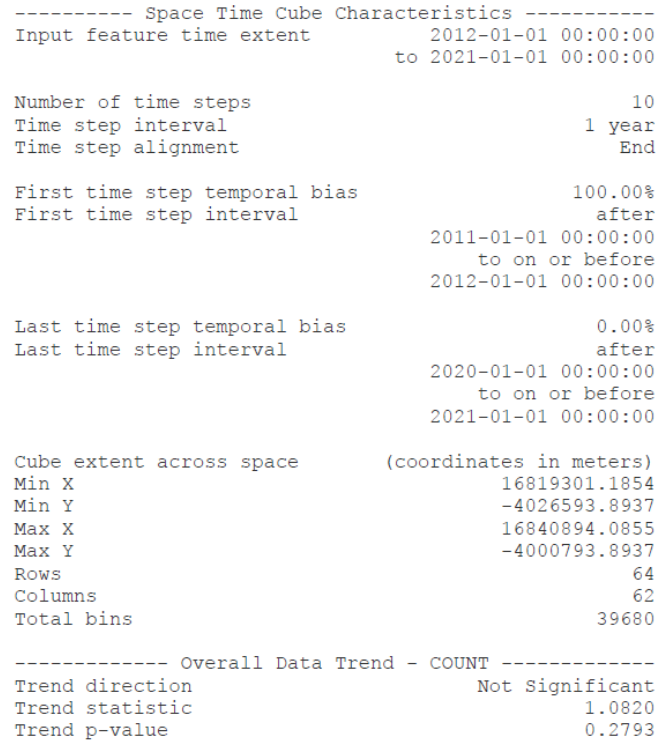
Figure A5. Limited-licence space-time cube logfile.